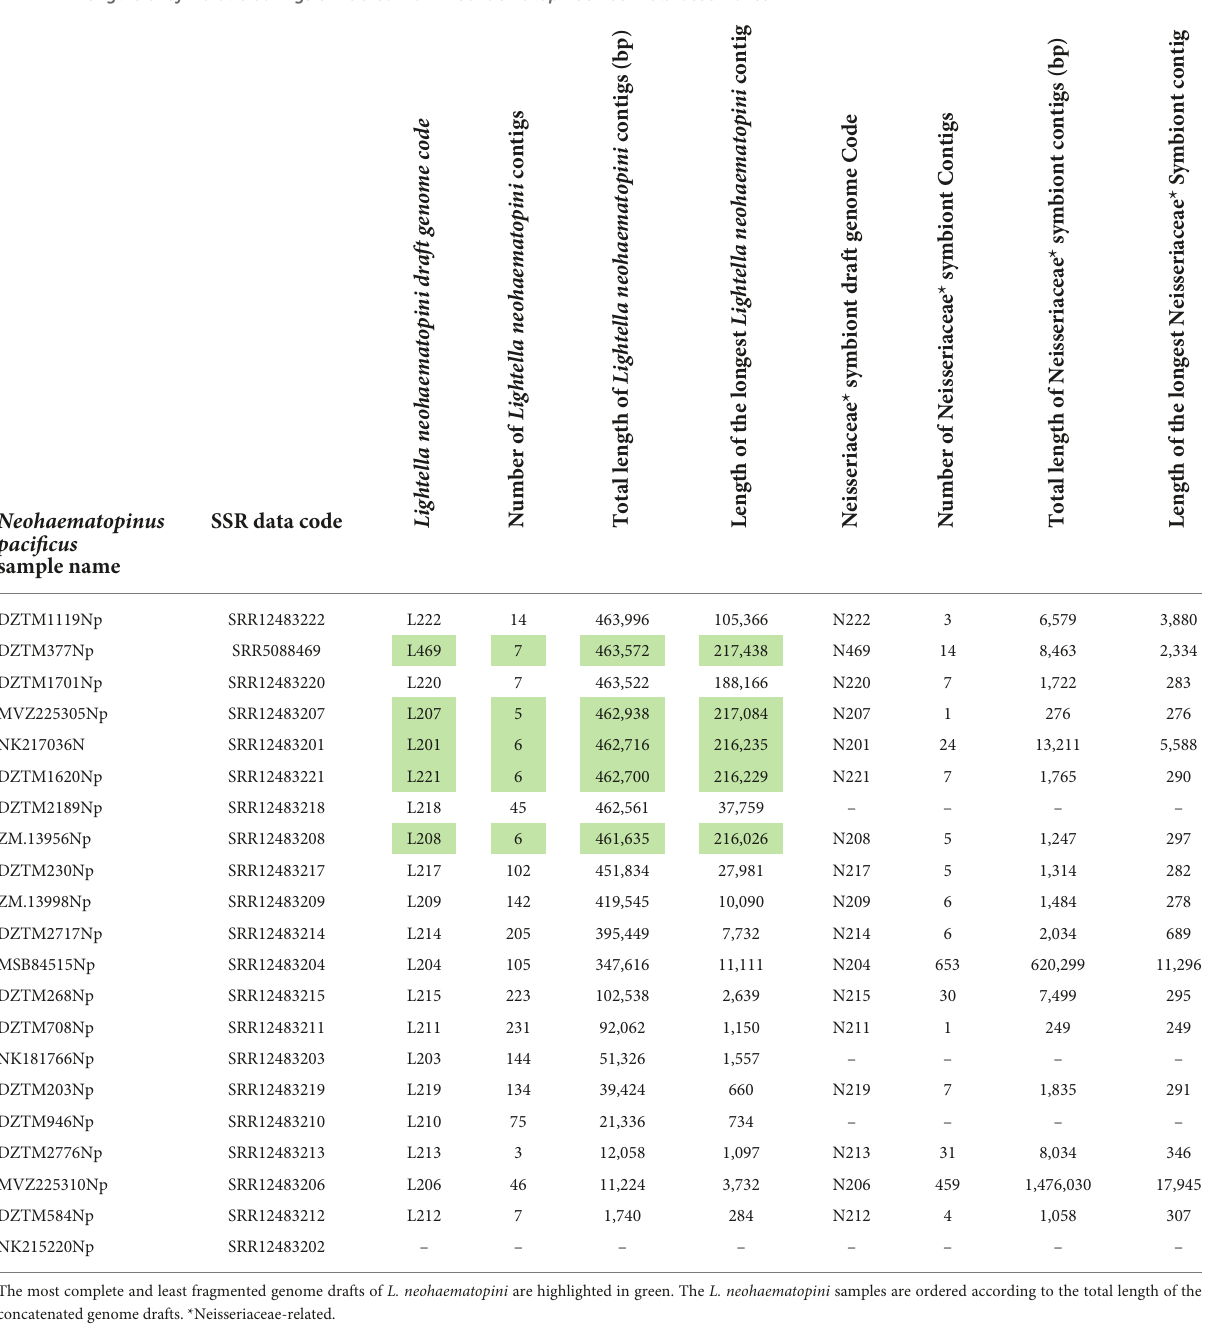
TABLE 2 Lengths of symbiotic contigs extracted from Neohaematopinus lice meta-assemblies.